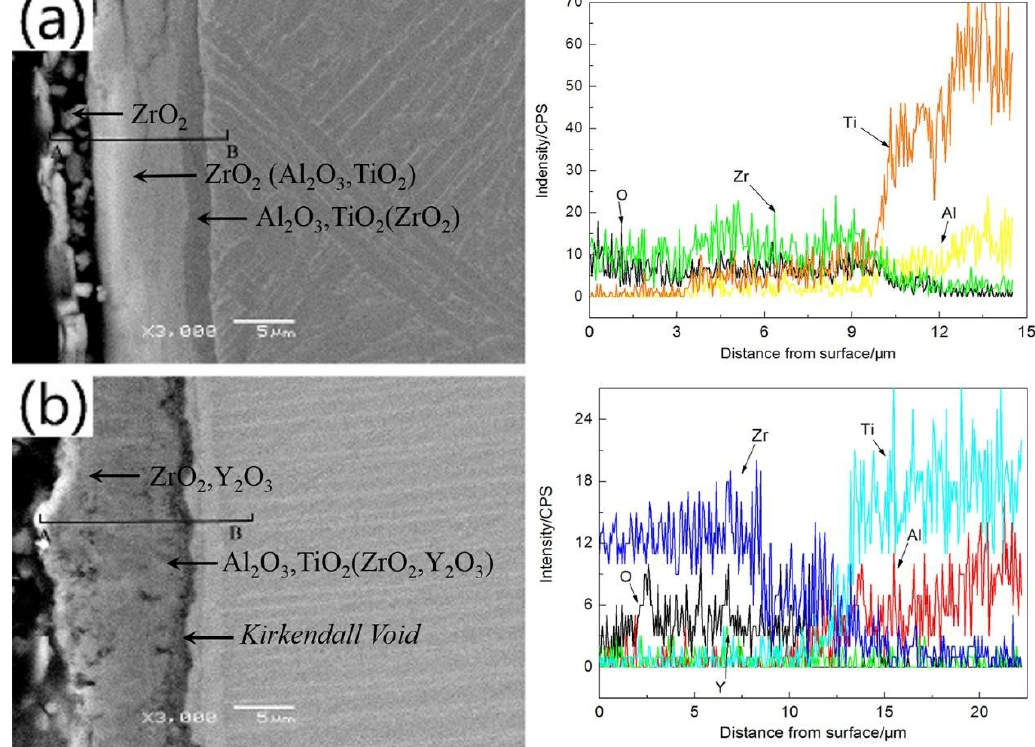
Figure 7. Cross-sectional morphologies and compositions of the specimens at 750 °C for 100 h: ( a ) Zr coating; ( b ) Zr-Y coating.